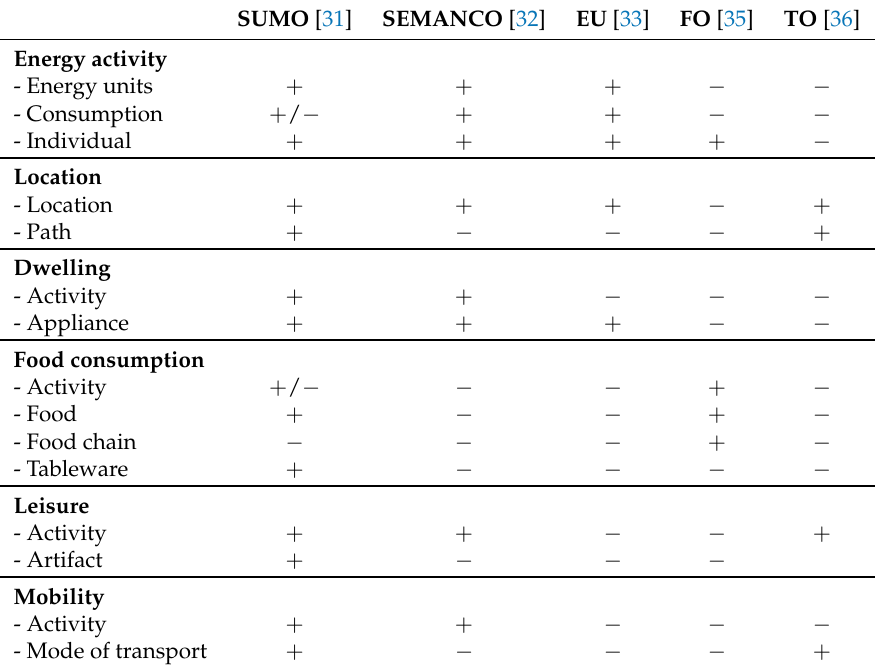
Table 1. Overview of the current state-of-the-art related ontologies with a focus on the previously distinguished domains of energy-consuming activities ( + : included; + / − : covered to some extent; − : not